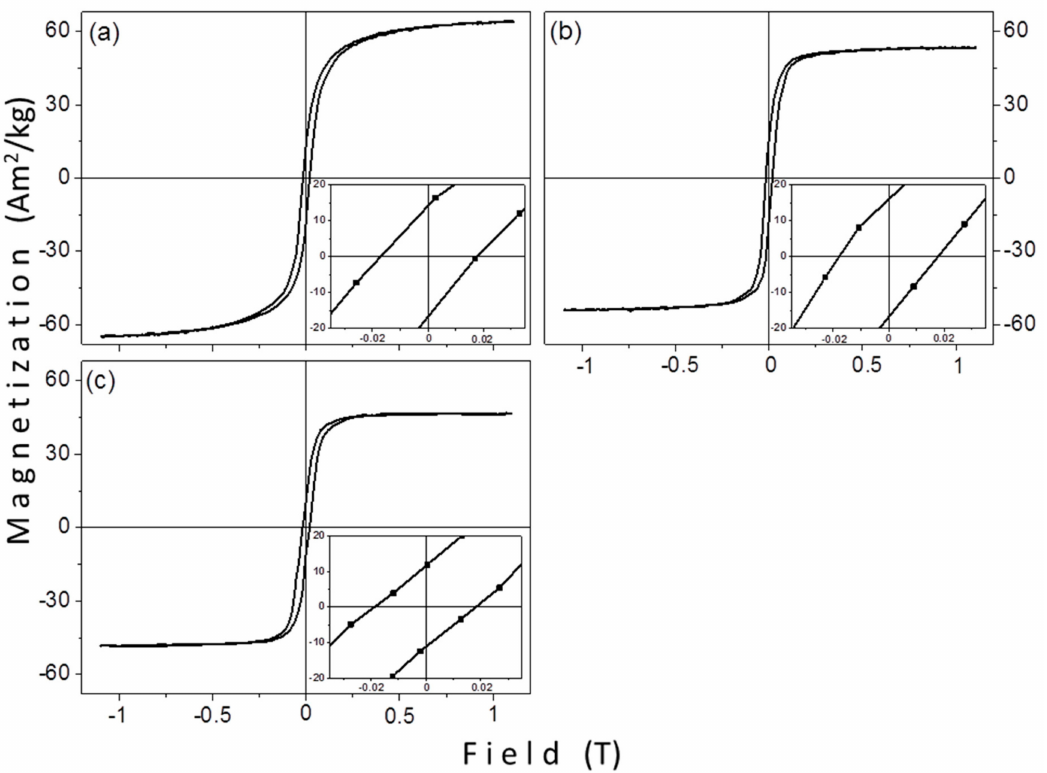
Figure 8. The hysteresis loops of the solvothermally synthesized samples: ( a ) SV5 prepared with TrEG, ( b ) SV6 with PEG-1000, and ( c ) SV7 with PEG-8000. Table 5. Magnetic features of samples SV5, SV6, and